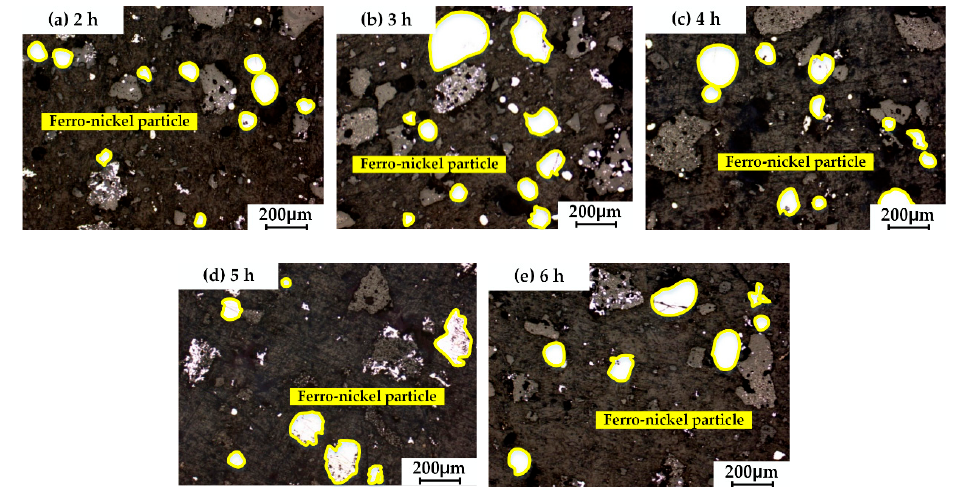
Figure 8. Optical microscope images of ferro-nickel particles under different reduction times: ( a ) 2 h; ( b ) 3 h; ( c ) 4 h; ( d ) 5 h; ( e ) 6 h.